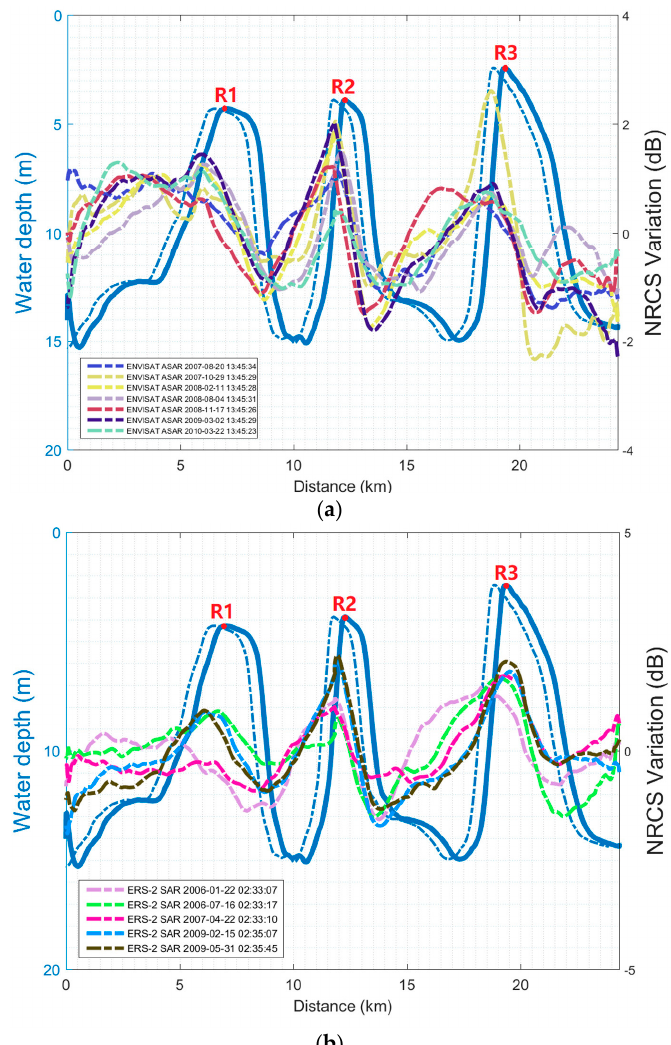
Figure 7. Same as Figure 5 but along the cross section B: ( a ) for ENVISAT ASAR images and ( b ) for ERS-2 SAR images. The locations of the crests of the three sand ridges along cross section B are marked as R1, R2, and R3, respectively. The blue dashed line is the same as the blue solid line but has a deviation of 0.5 km westward.